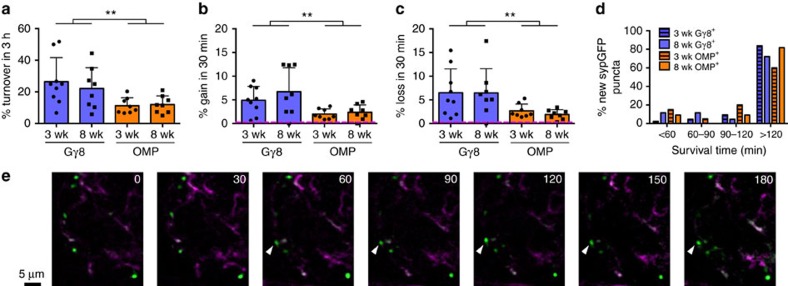
Rapid and continuous turnover of OSN presynaptic terminals.(a) Percentage turnover of sypGFP puncta over 3 h. P=0.002 Gγ8 versus OMP; P=0.23, 3-week old versus 8-week old, two-way ANOVA. (b) Mean percentage gain of new sypGFP puncta over 30 min. P=0.002 Gγ8 versus OMP, P=0.32, 3-week old versus 8-week old, two-way ANOVA. (c) Mean percentage loss of existing sypGFP puncta over 30 min. P=0.001 Gγ8 versus OMP; P=0.56, 3-week old versus 8-week old, two-way ANOVA. Magenta dashed lines in b,c indicate potential contribution of movement noise (Methods and Supplementary Fig. 4C). In a–c, mean±s.d. is shown. (d) Survival time of newly-formed sypGFP puncta. (e) Time-lapse image series of single optical sections from two-photon z-stack showing formation of new sypGFP punctum (arrowhead) at t60, which persists throughout the remainder of the imaging session (survival time >120 min).